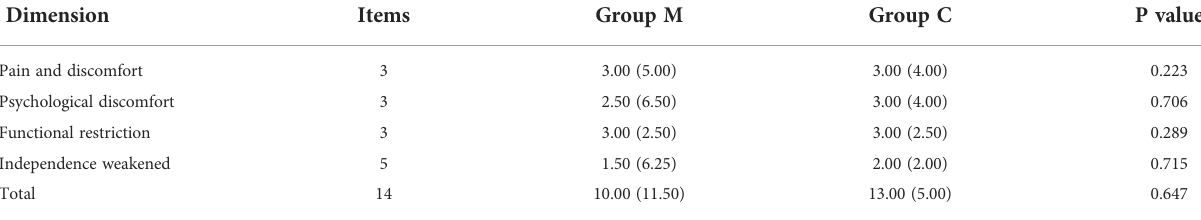
TABLE 1 OHIP-14 (14-item Oral Health Impact Degree Scale)scores of the study participants.